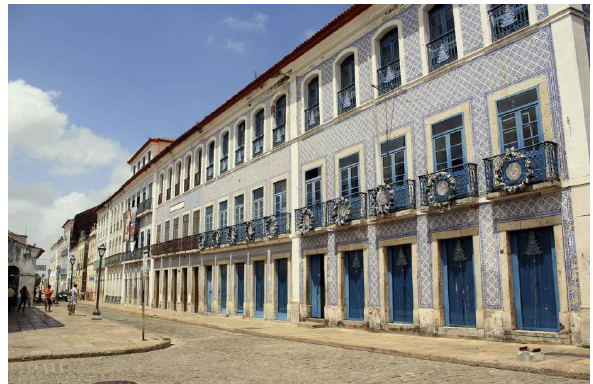
Figure 2. Buildings in the historical center of S˜ao Lu´ıs. (Figueiredo et al., 2011)